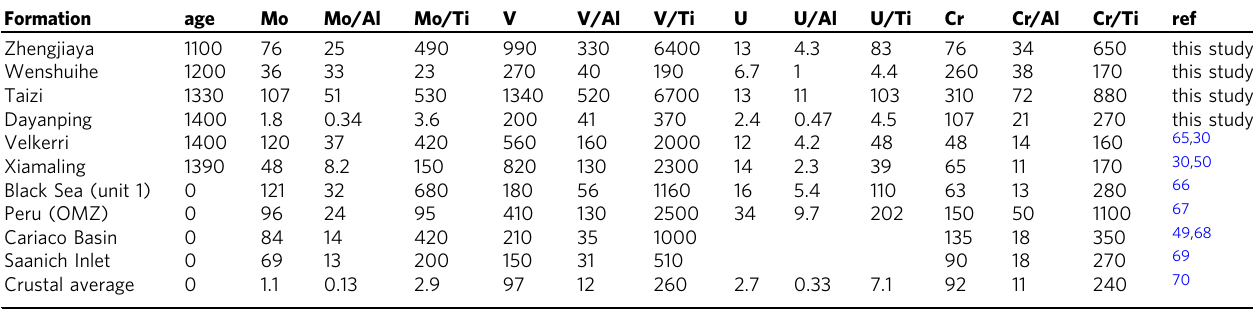
Table 1 Maximum trace metal concentrations and enrichments Mesoproterozoic shales and modern sediments from anoxic environments